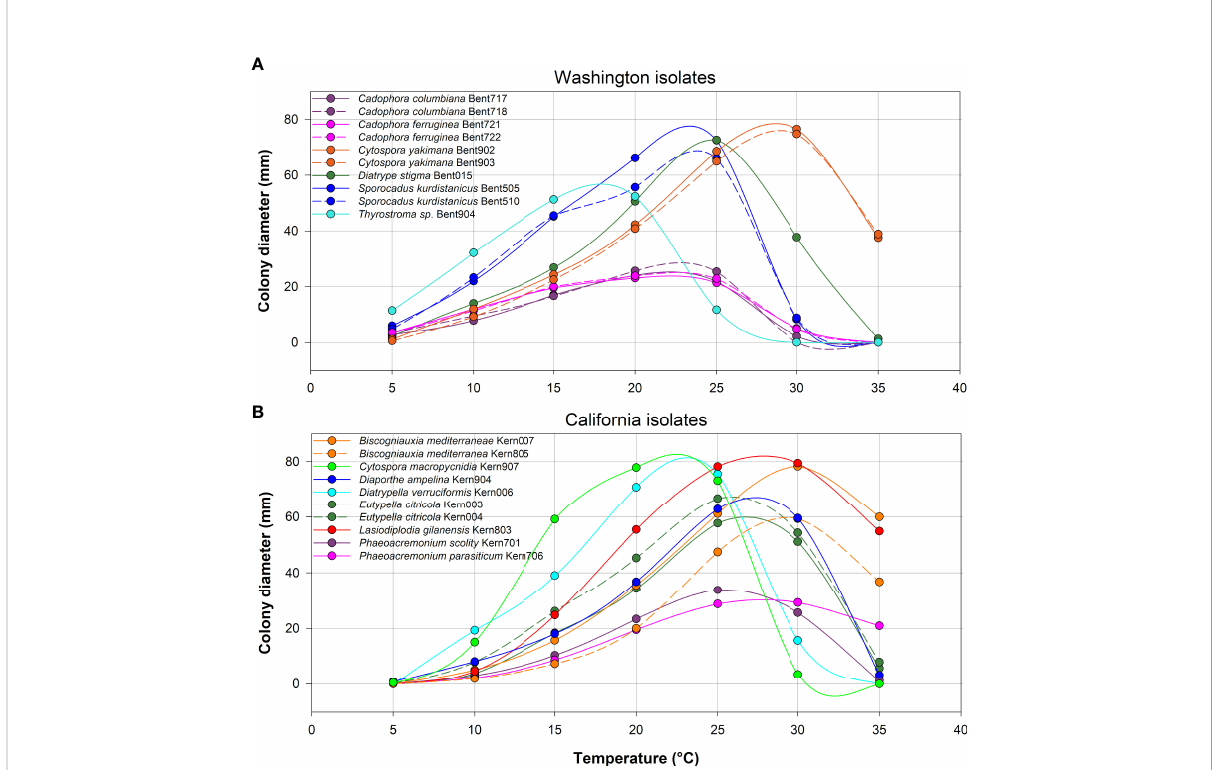
FIGURE 8 Average colony diameter of ten isolates from Washington (A) and ten isolates from California (B) assessed at temperatures ranging from 5 to 35°C in 5°C increments. At each temperature, three media dishes were used per isolate in each of two